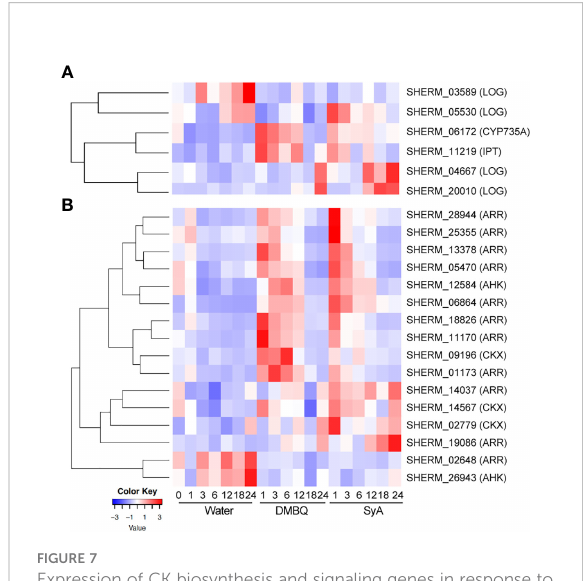
FIGURE 7 Expression of CK biosynthesis and signaling genes in response to DMBQ and SyA during prehaustorium formation. (A) The expression patterns of genes involved in CK biosynthesis (CYP735A, IPT, LOG) and (B) signaling and catabolism (AHK, ARR, CKX) were shown as